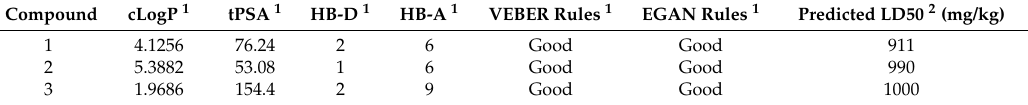
Table 2. Physicochemical and toxicological properties of TbTIM